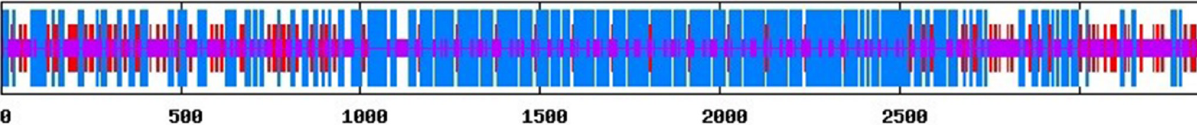
Fig 1. Secondary structure of polyketide synthase 3 in A . limacinum . Note: The longest blue stub show Alpha helix, the longer red stub show Extended strand and the shortest orange show Random coil.